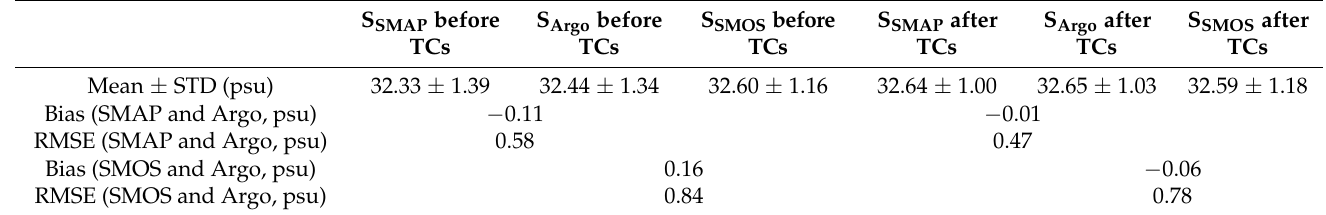
Table 2. Comparison of satellite product (S SMAP and S SMOS ) and Argo (S Argo ) salinity data before and after 10 TCs. ∆ represents differences between Argo and satellite observations (S SMAP or SOMS -S Argo ); bias represents mean difference (bias = ∆ ). STD, standard deviation; RMSE, root mean square error. S SMAP